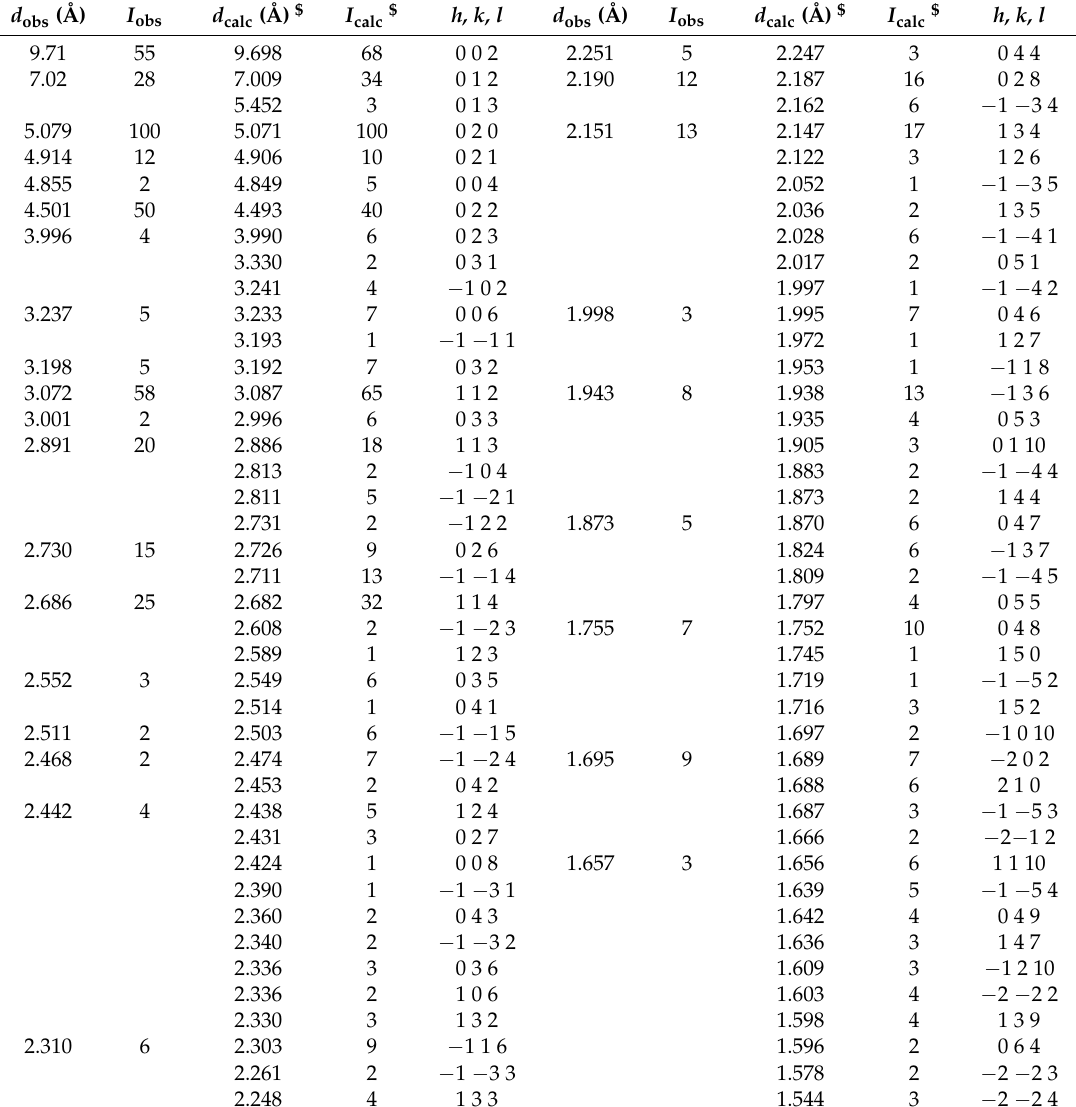
Table 2. X-ray powder diffraction data for